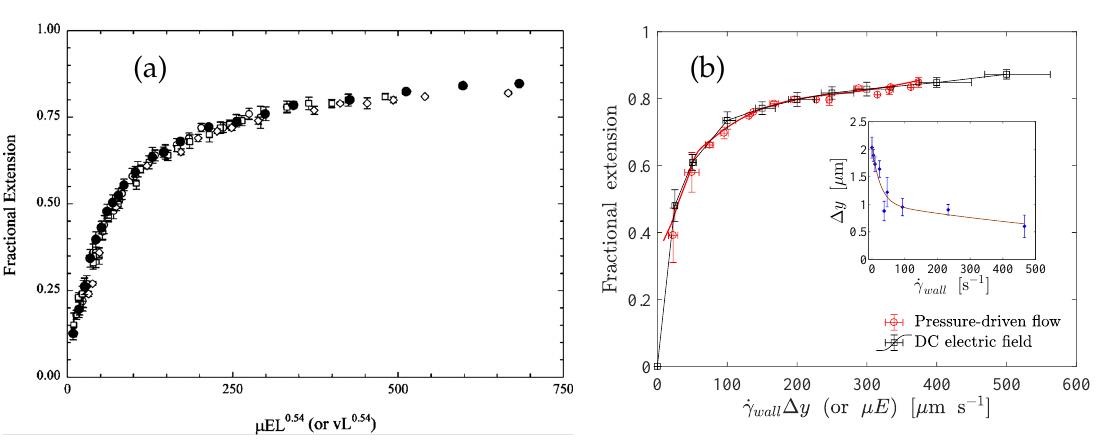
Figure 9. Experimental results demonstrating the electro-hydrodynamic equivalence principle (EHEP) Figure 10. Experimental results demonstrating the EHEP for (a) end-tethered unconfined DNA for ( a ) end-tethered unconfined DNA molecules [26] and ( b ) end-tethered DNA molecules at the molecules [26] and (b) end-tethered DNA molecules at the surface of shallow microchannels [92]. surface of shallow microchannels [92].